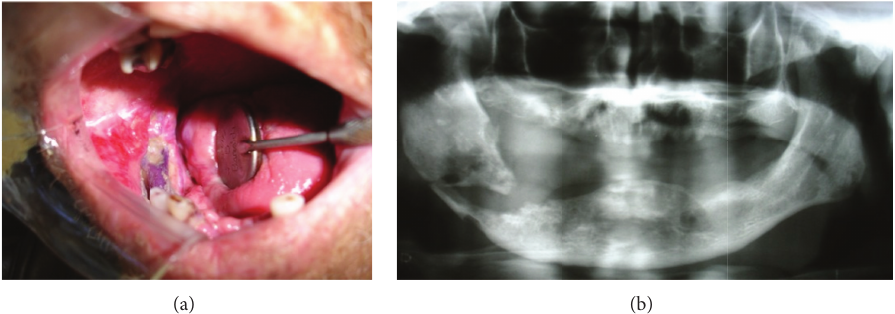
Figure 4: (a) Clinical aspects of osteoradionecrosis showing bone exposure of the operated area. (b) Panoramic radiograph showing pathological fracture in the